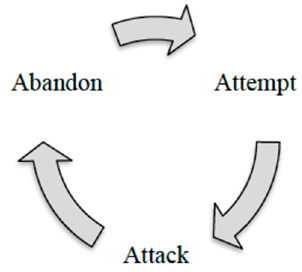
Figure 1. The attempt, attack, abandon Cycle.